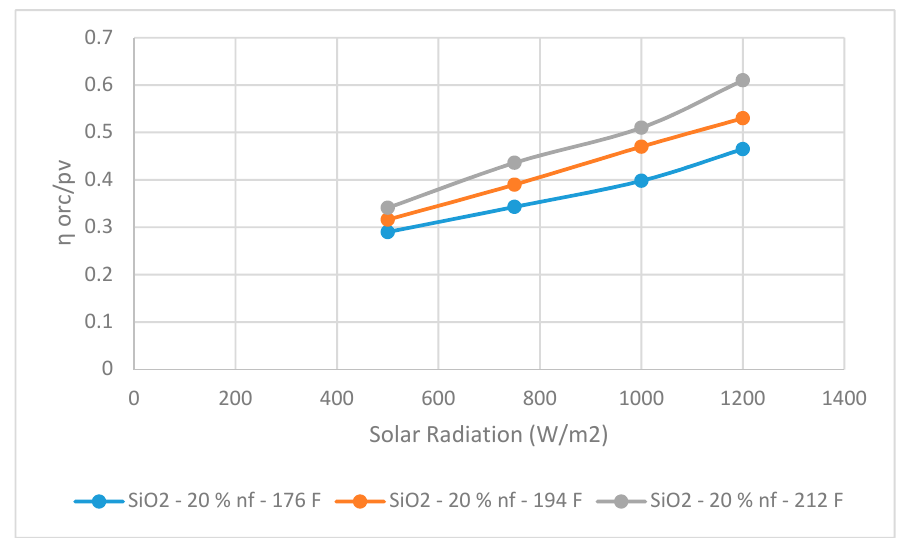
Figure 2. Logical diagram for numerical solution.